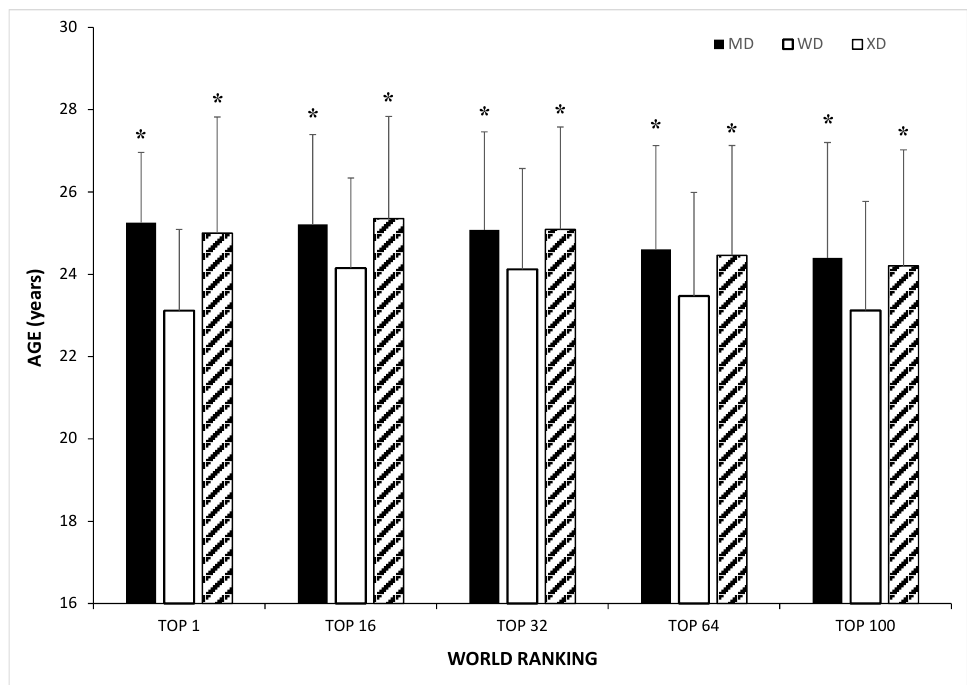
Figure 2. Mean-age at which badminton players reached their highest position in the World Rank- ing. MD: men’s doubles, WD: women’s doubles and XD: mixed doubles. * Significant differences compared to WD ( p < 0.05).